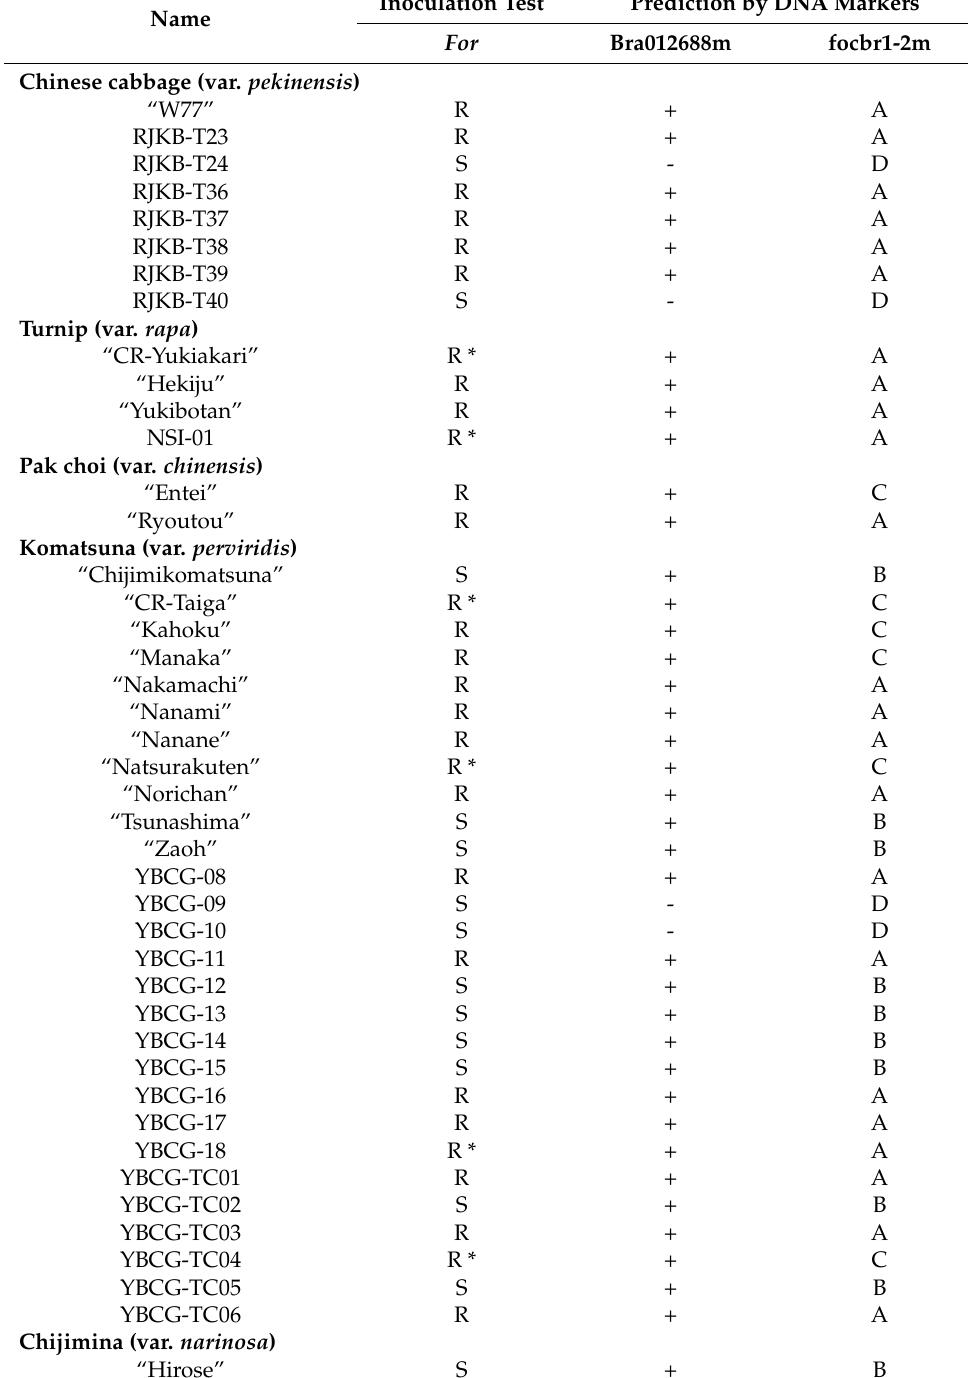
Table 3. F. oxysporum f. sp. rapae resistance and FocBr1 genotype determined by focbr1-2m